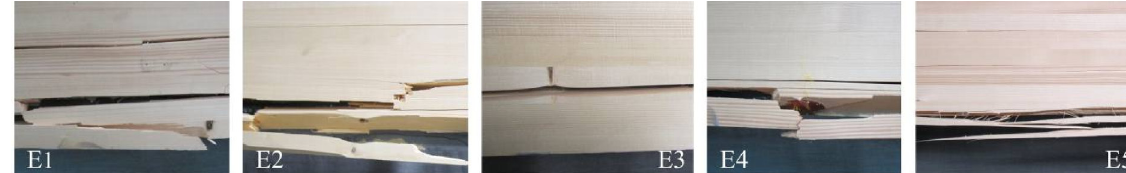
Fig. 3. Failure mechanism of Series E reinforced